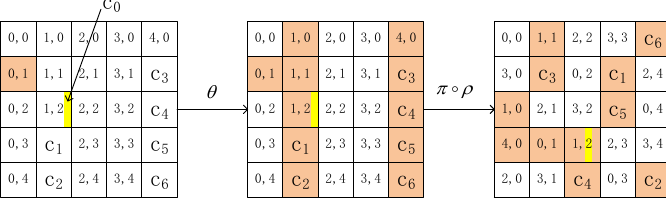
Figure 13: Property 2 Revised